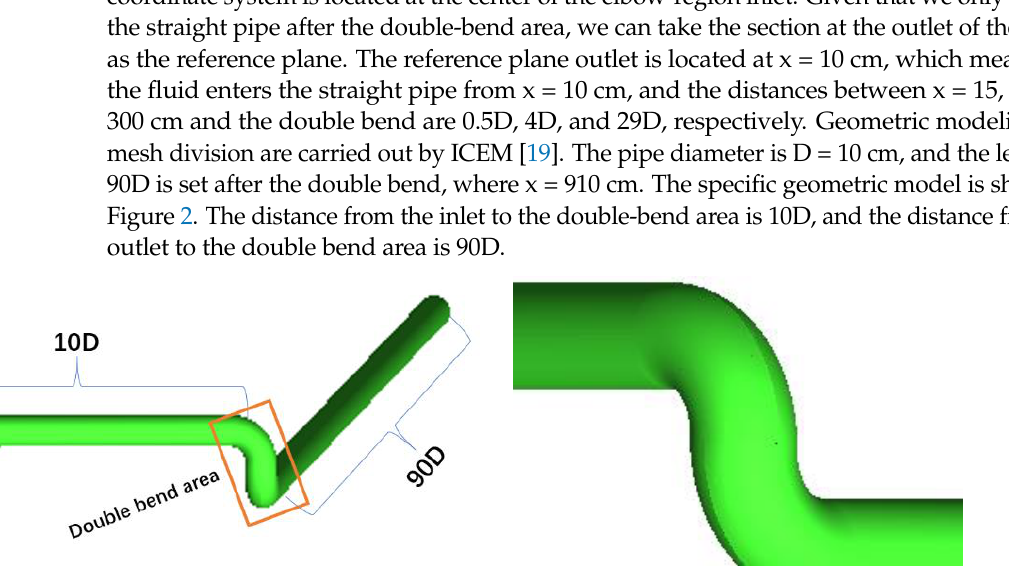
Figure 1. Schematic diagram of time-difference measurement.